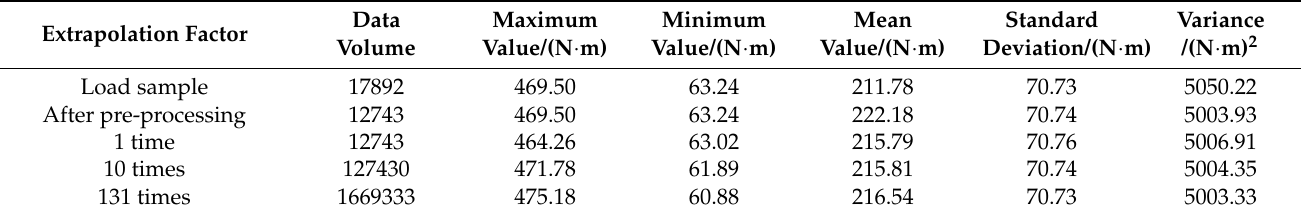
Table 5. Statistical characteristics of power take-off (PTO) load spectrum after extrapolation.